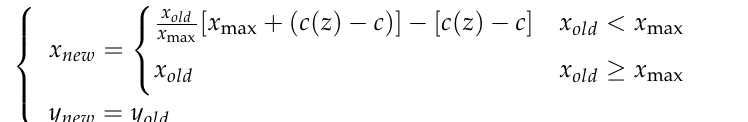
( b ) Figure 1. Design of wavy leading edges: ( a ) structure of the wavy-leading-edge airfoil; ( b ) spanwise- section generation method. The chord length of the airfoil with a wavy leading edge varies spanwise according to the following formula. (1) The averaged chord length and projected area of the airfoil with a wavy leading edge are kept the same as the baseline airfoil by stretching or compressing the x -axis. The